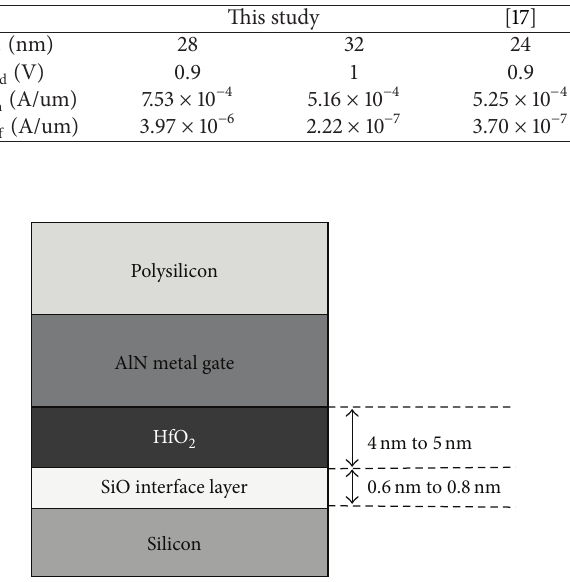
Figure3:Gatestackcross-sectionalprofileofthetestbedPMOSFET with variation in sublayers.